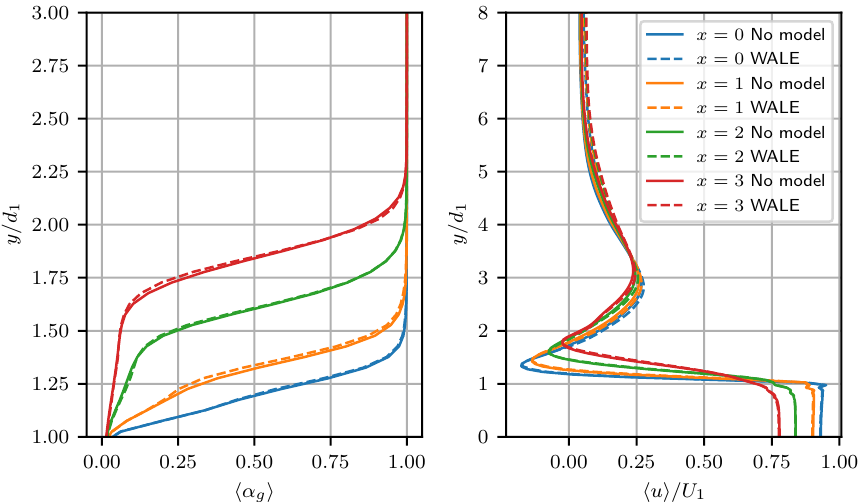
Figure A1. Effect of explicit SGS modelling using the WALE model. Profiles of the volume fraction of air ( left ) and streamwise velocity ( right